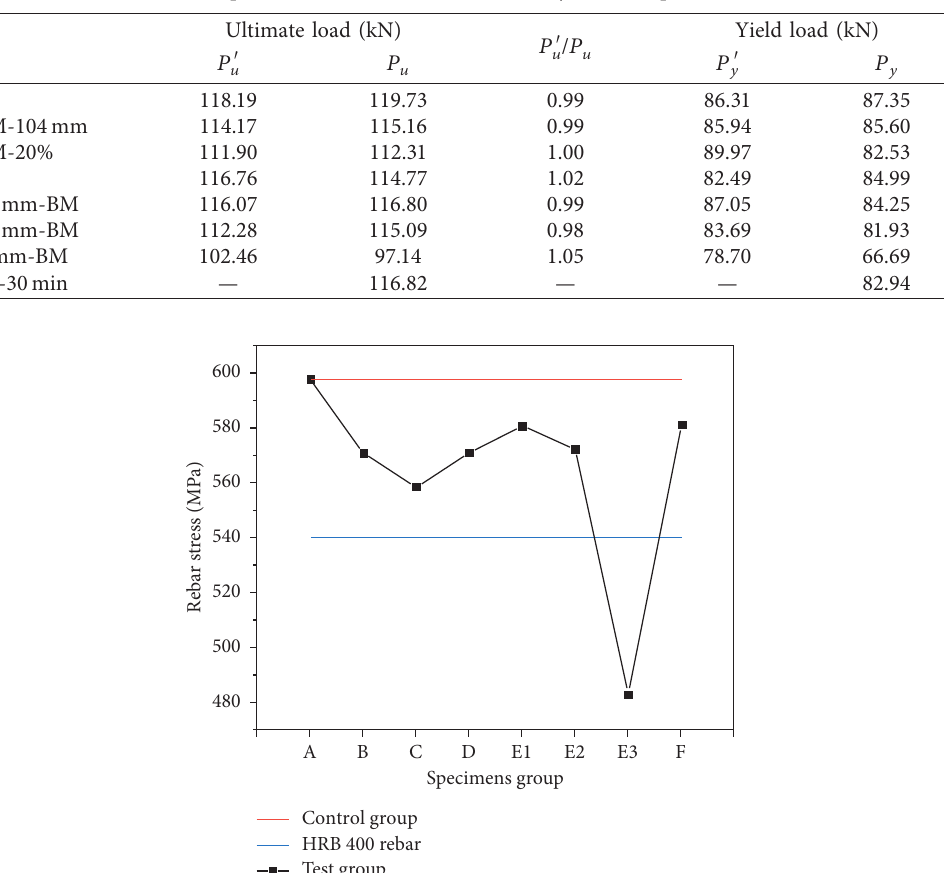
Table 10: Comparison between finite element analysis and experimental results.